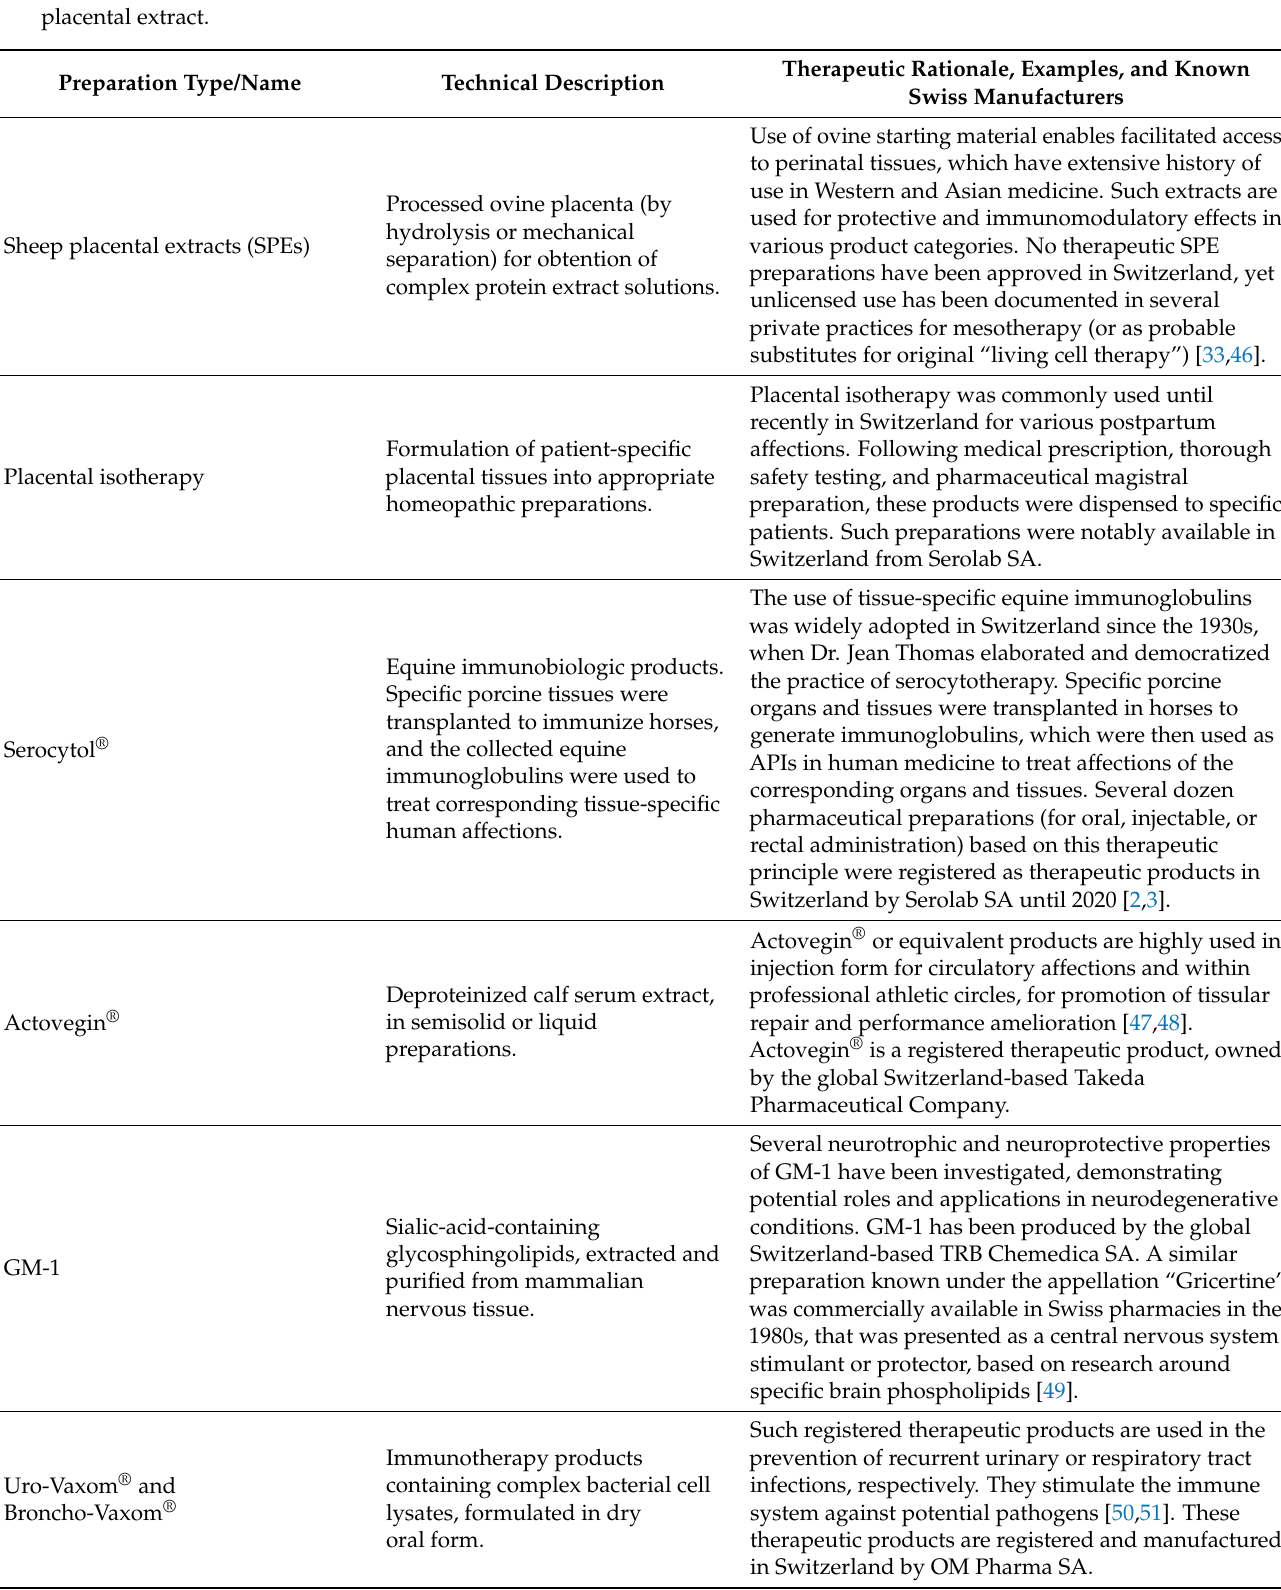
Table 1. Selective overview of various therapeutic preparation types historically linked to the Swiss market. Although not considered as cell therapies, the listed preparation types all revolved around the use of specific tissues, biological extracts, immunoglobulins, or serum-based components. Therein, product specificity constituted a cornerstone of most therapeutic principles, despite technological or formulation differences. APIs, active pharmaceutical ingredients; SPE, sheep placental